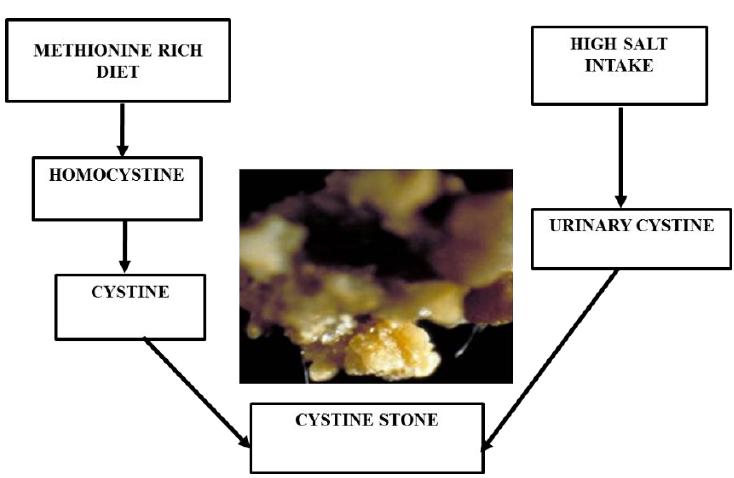
Figure 4. Cystine stone formation with food habits.